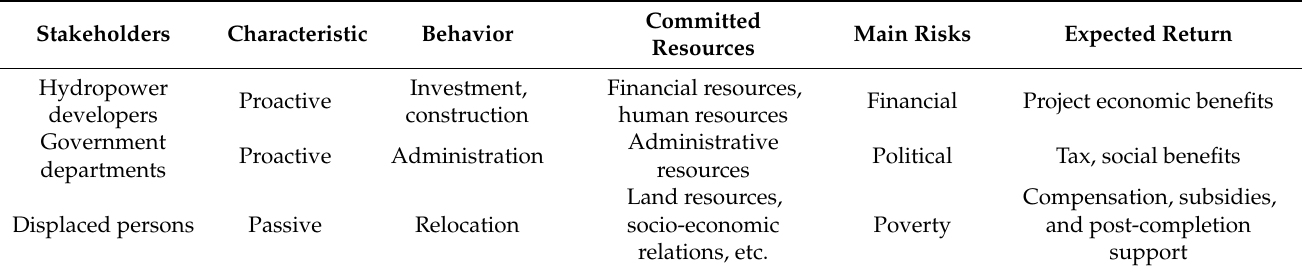
Table 1. Stakeholder characteristics of hydropower